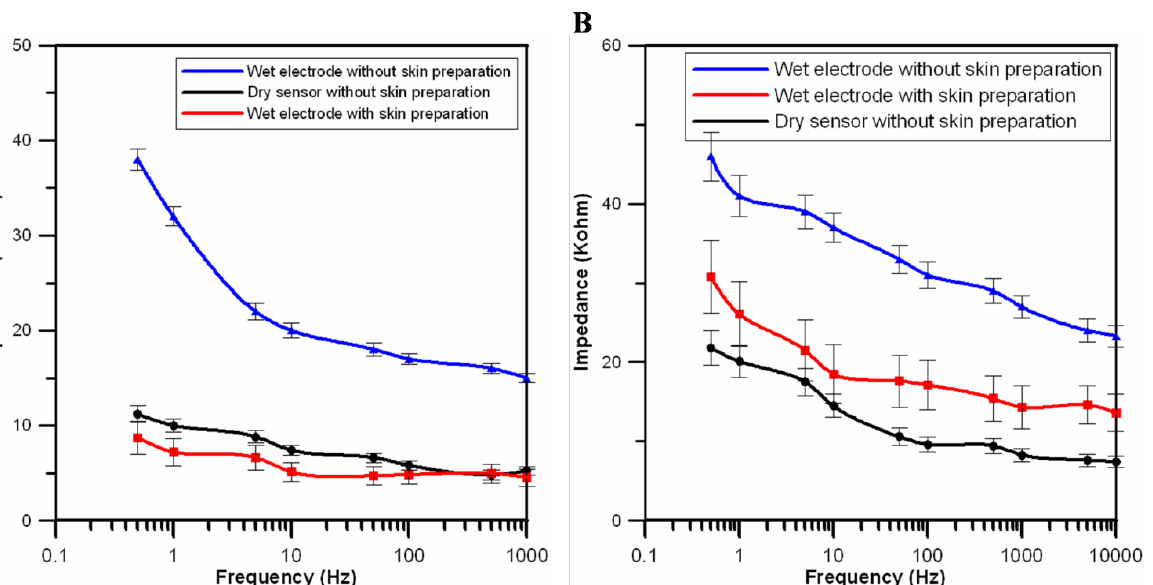
Figure 5. Impedance change data representing the skin-electrode interface on the ( A ) forehead (F10) and ( B ) at hairy sites